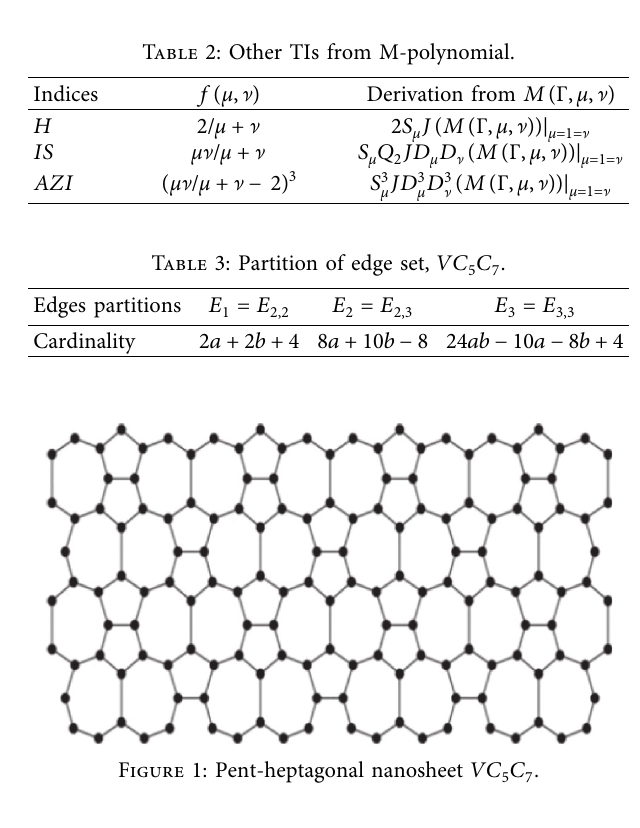
Table 2: Other TIs from M-polynomial.